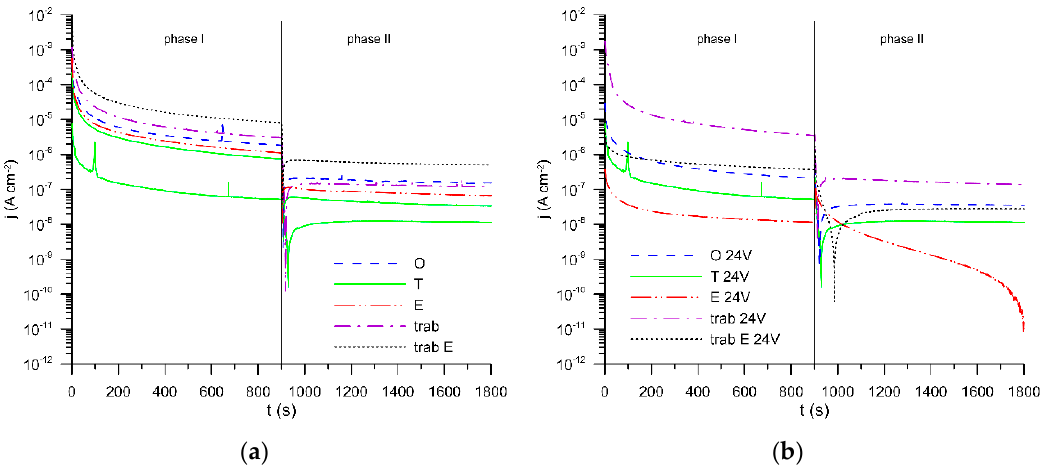
Figure 7. The potentiostatic curves at 850 mV/SSCE measured according to ASTM F746 of specimens in physiological solution: ( a ) surfaces without anodization, ( b ) anodized surfaces.